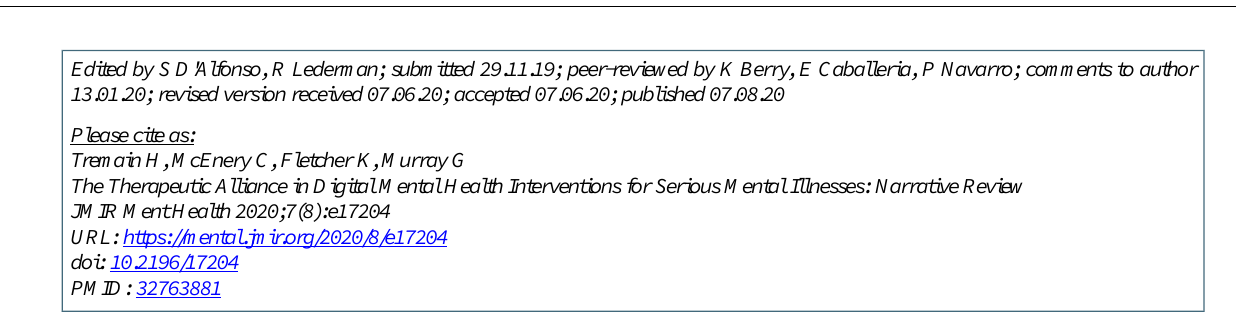
PTSD: posttraumatic stress disorder RCT: randomized controlled trial VR: virtual reality WAI: Working Alliance Inventory